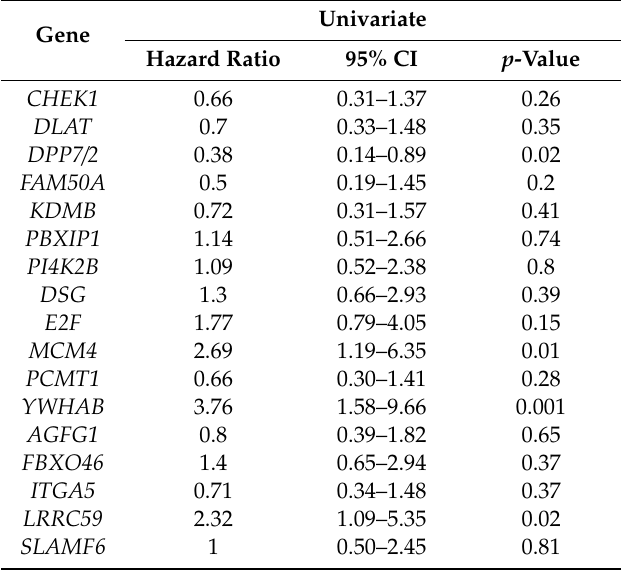
Table 3. Univariate Cox regression analysis of the genes included in this panel.